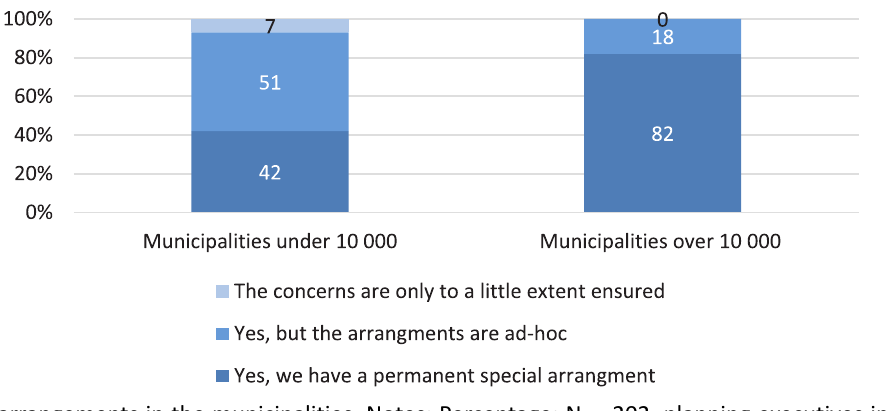
Figure 1. Special arrangements in the municipalities. Notes: Percentage; N = 202, planning executives in municipalities; data from 2018.